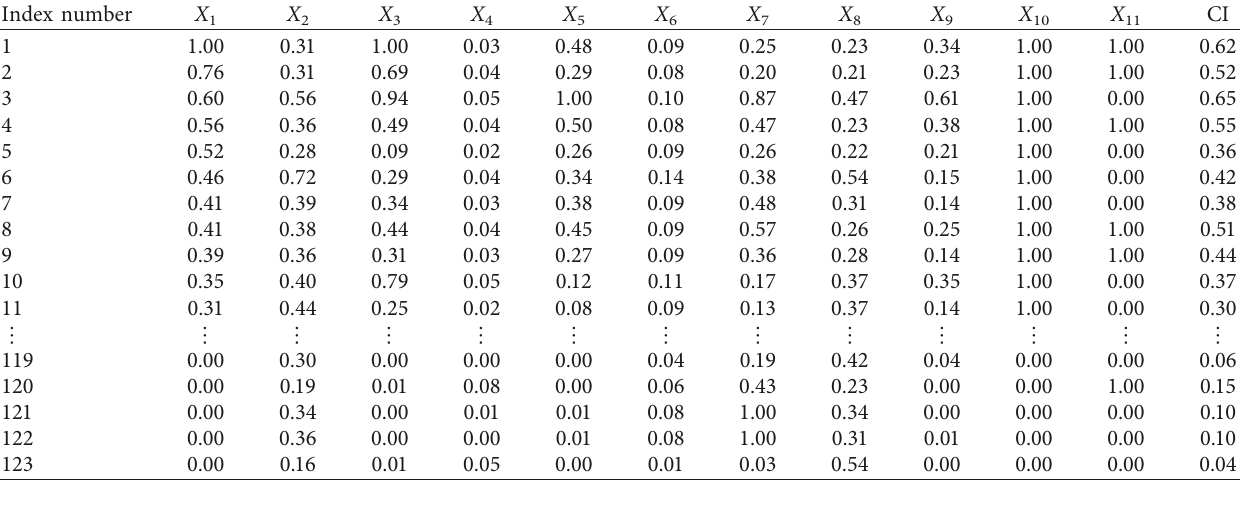
Table 3: Normalized result of training data